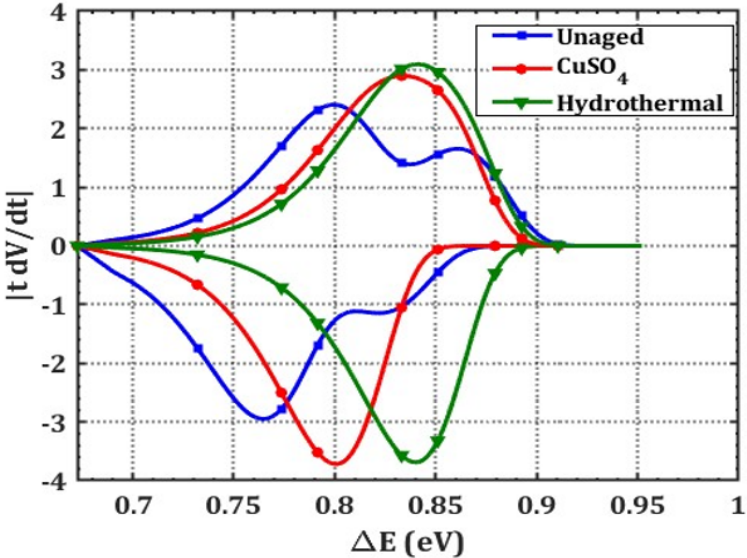
Figure 7. Variation in trap density as a function of trap depth for a ± DC input voltage. Table 2. Mean lifetime and trap parameters of XLPE under DC voltage.